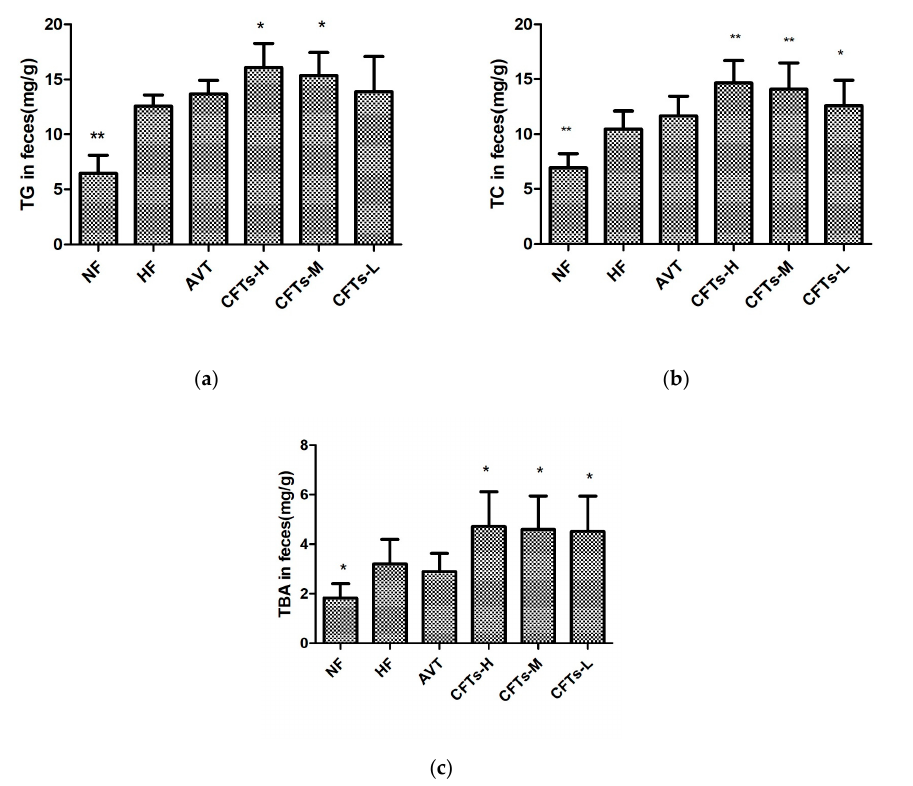
Figure 5. The main index in rats feces. Fecal TC ( a ), TG ( b ) and TBA ( c ). These data are presented as means ± SD ( n = 10). Compared to HF, * p < 0.05; ** p < 0.01.